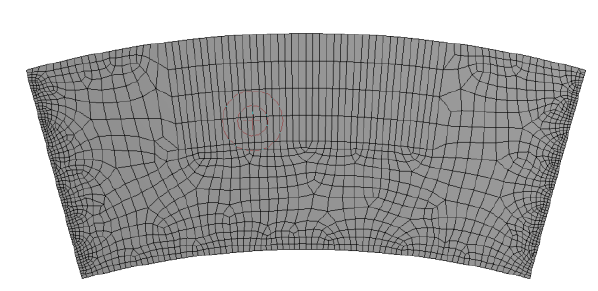
Fig. 3. Radial clearance geometry.